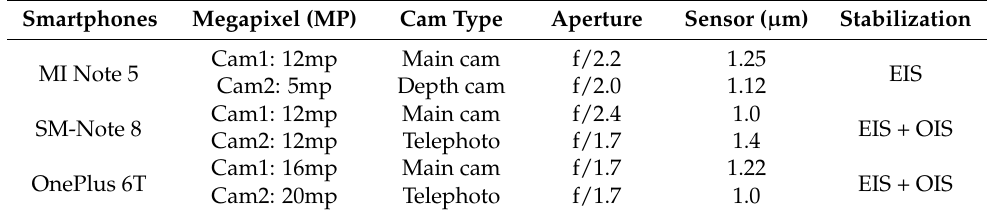
Table 1. The Aperture column of Table 1 denotes the focal length of the smartphone camera. Table 1. Android smartphones camera